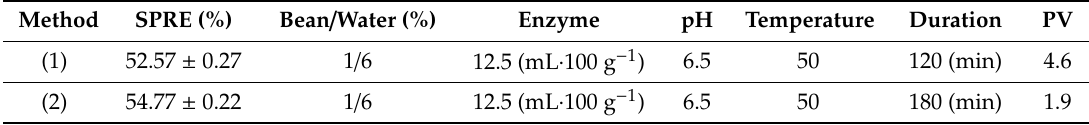
Table 2. Comparison of the SPRE in the enzymatic hydrolysis with and without thermal treatment.